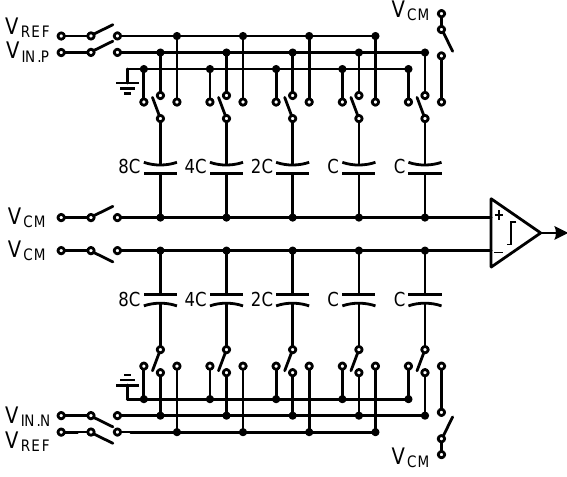
Figure 6. Simulated result of the pulse-width modulator for different weight code ( W IN ).